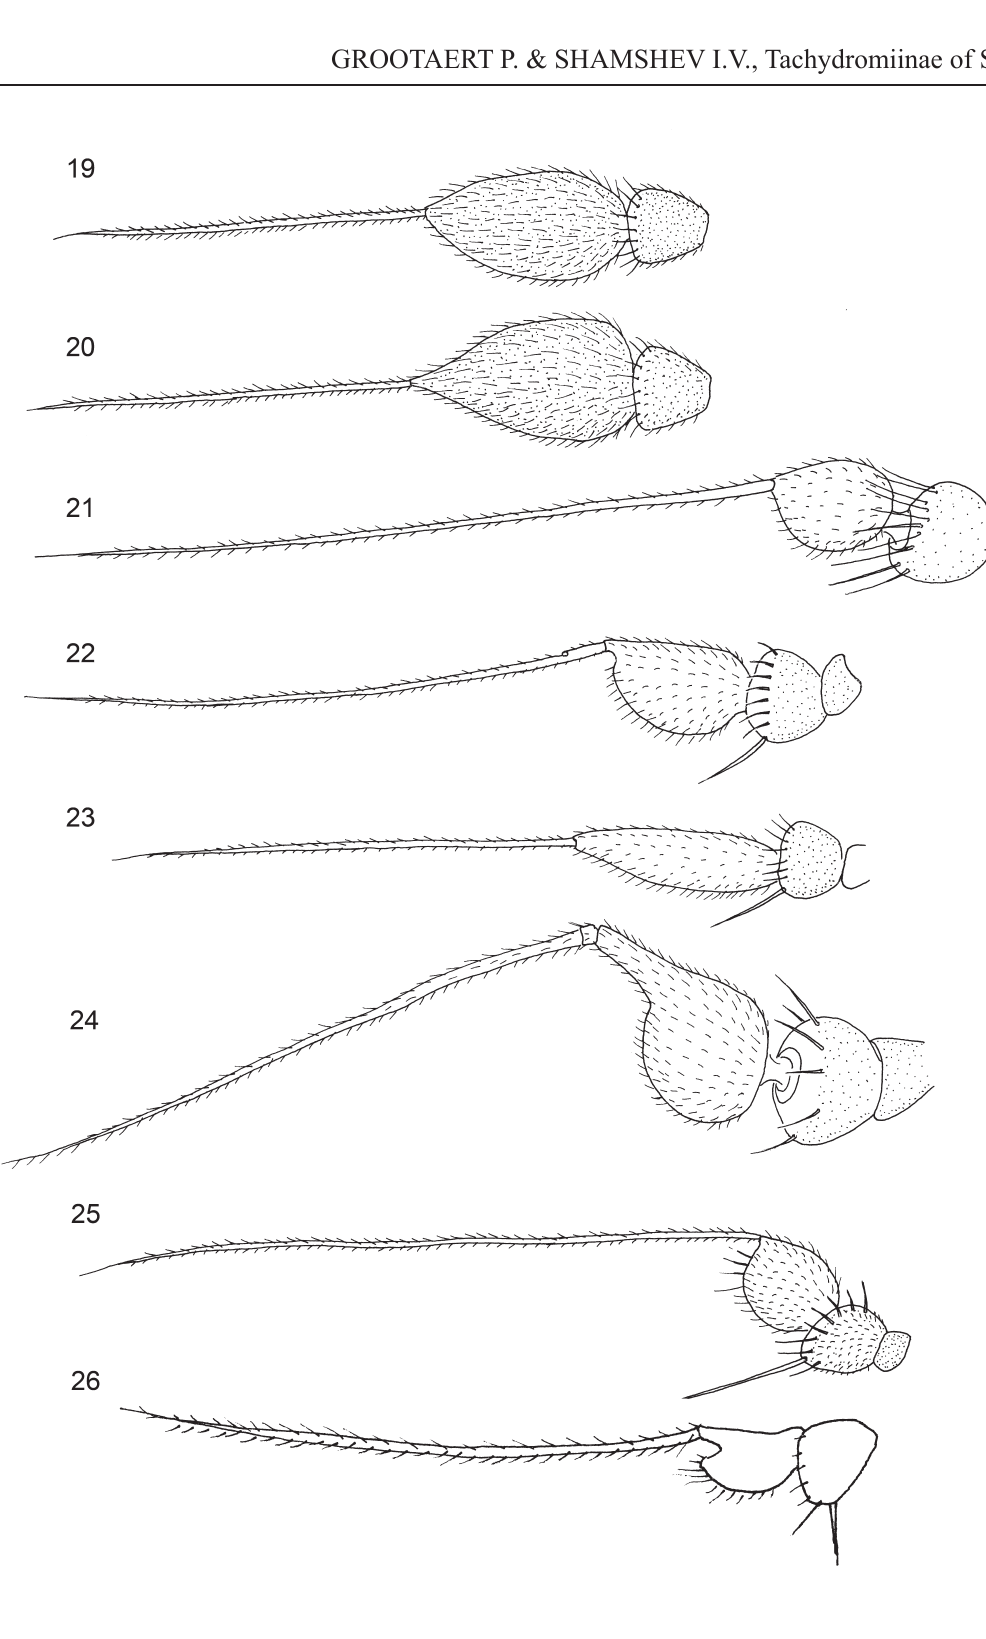
Figs 19-26. Antennae of Tachydromiinae. 19 . Platypalpus singaporensis sp. nov. 20 . Platypalpus hualuang Grootaert & Shamshev, 2006. 21 . Tachydromia luang Shamshev & Grootaert, 2005. 22 . Drapetis mandai sp. nov. 23 . Drapetis hutan sp. nov. 24 . Chersodromia singaporensis Shamshev & Grootaert, 2005. 25 . Crossopalpus temasek sp. nov. 26 . Stilpon singaporensis sp.